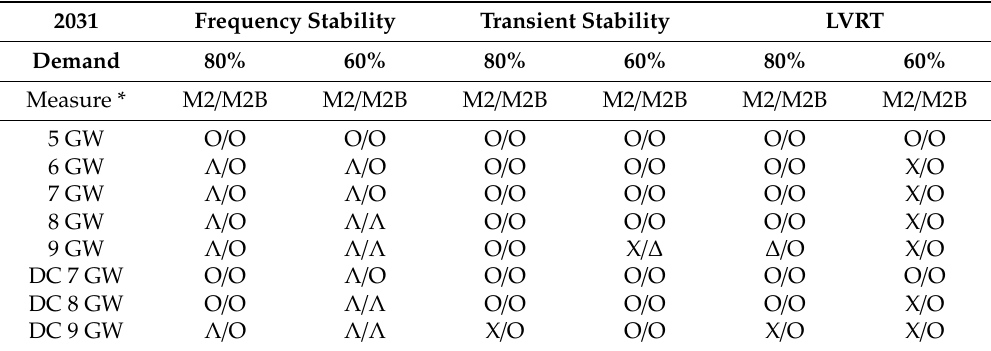
Table 21. Summary of additional dynamic analysis after installing an energy storage system (ESS) and synchronization condenser